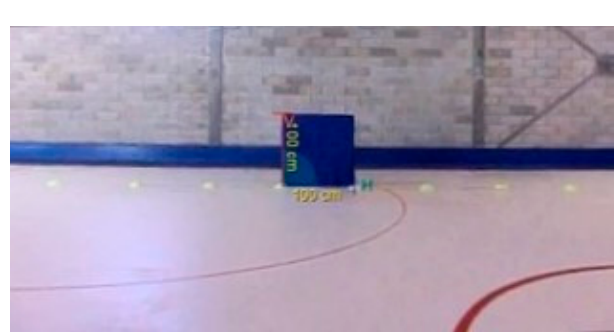
Figure 1. Shooting field